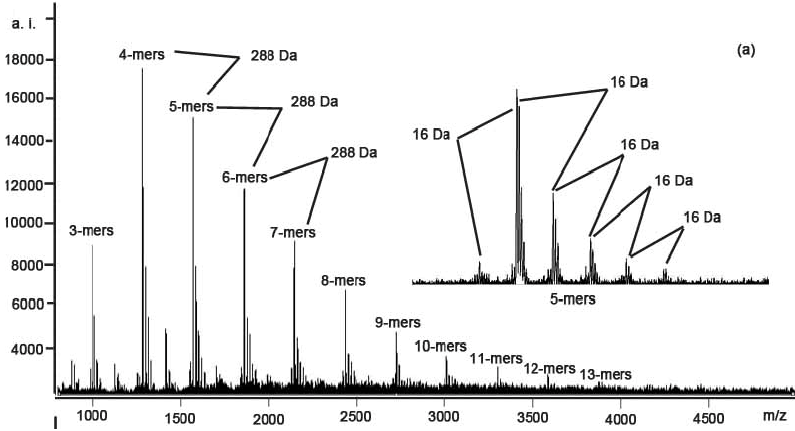
Figure 1. MALDI-TOF positive reflectron mode mass spectra of the condensed tannins from (a) stem bark and (b) fine root of C. equisetifolia